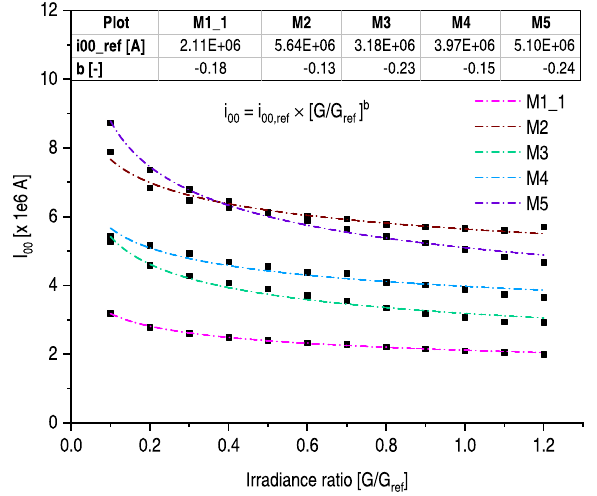
Fig. 5 Variation of I00 with illumination for fi ve module samples. Fitting is used to obtain the power factors. The inset table shows the results of the fi t.